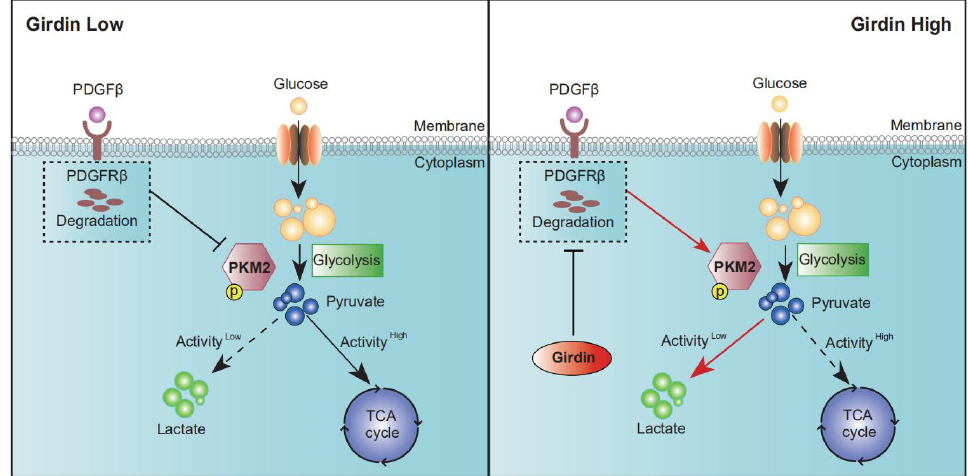
Figure 6. Girdin enhances the Warburg effect by restraining PDGFRβ degradation and PKM2 activity. A hypothetical model illustrating the functional role of Girdin in the Warburg effect. Girdin inhibits PKM2 activity by blocking PDGFRβ degradation, relieving its suppression effect on PKM2 phosphorylation, and eventually up-regulating the Warburg effect.